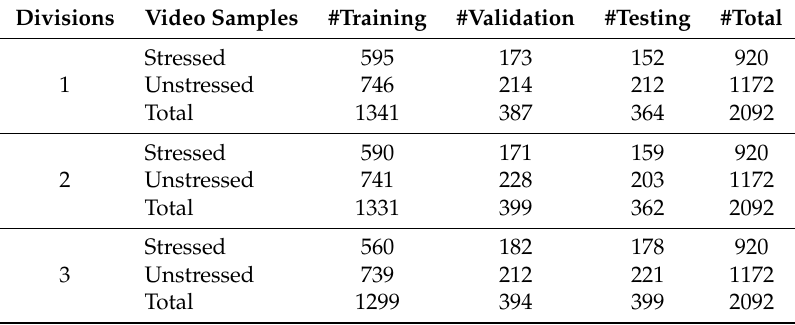
Table 1. Video samples used for training, validation, and